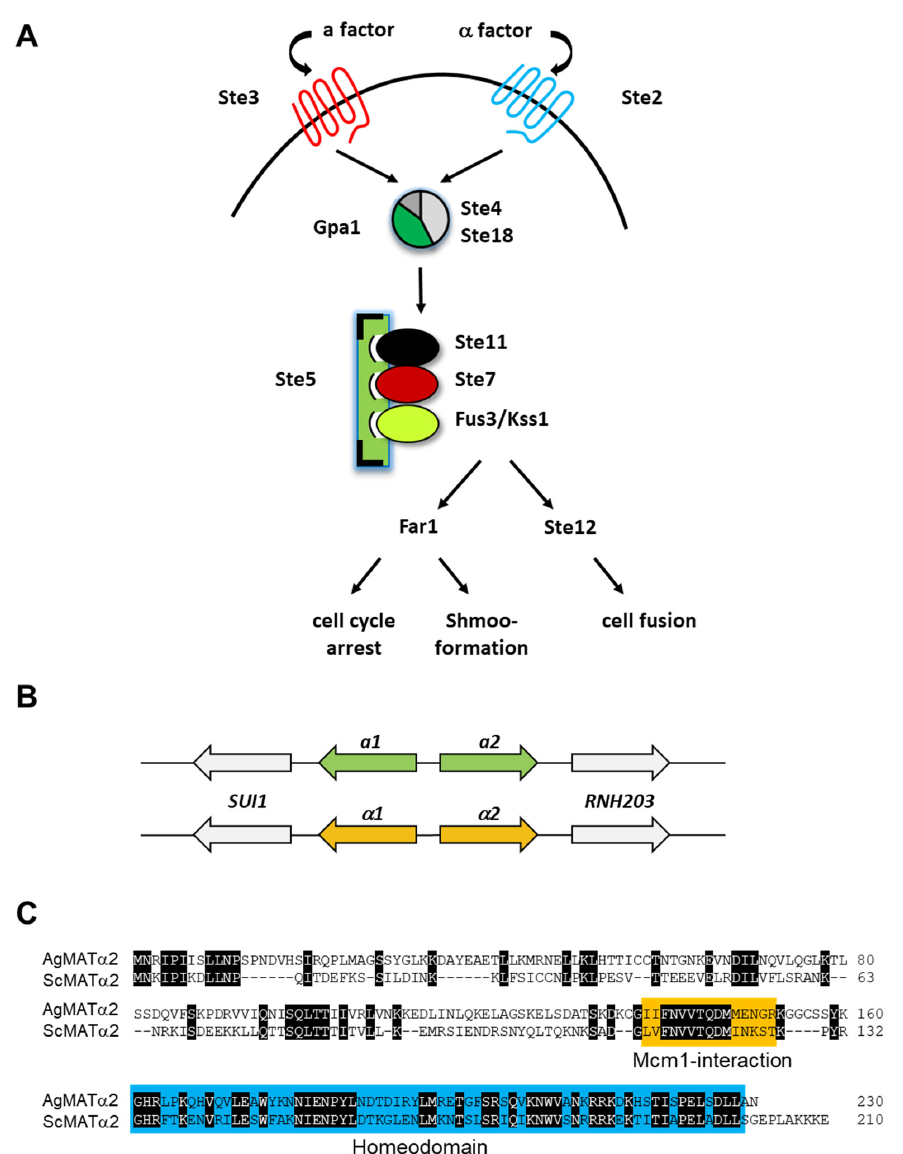
Figure 2. Mating type and pheromone signal transduction cascade. ( A ) The pheromone signal transduction cascade and its Ashbya genes based on S. cerevisiae . In S. cerevisiae there are three outputs of the cascade resulting in fusion of cells of opposite mating type and karyogamy to form diploid zygotes. The output of this cascade in Ashbya remains to be elucidated as mating has not been observed. For phenotypic characterization of mutant strains, refer to Table 1. ( B ) MAT -loci of Ashbya gossypii showing either MAT a or MAT α with the highlighted mating type genes a 1, a 2 and α 1 and α 2 and adjacent genes. ( C ) Overexpression of S. cerevisiae α 2 blocks sporulation in Ashbya . A protein alignment of Ashbya and S. cerevisiae α 2 is shown marking conserved amino acids (shaded in black), the Mcm1-interacting domain and the C-terminal homeodomain.